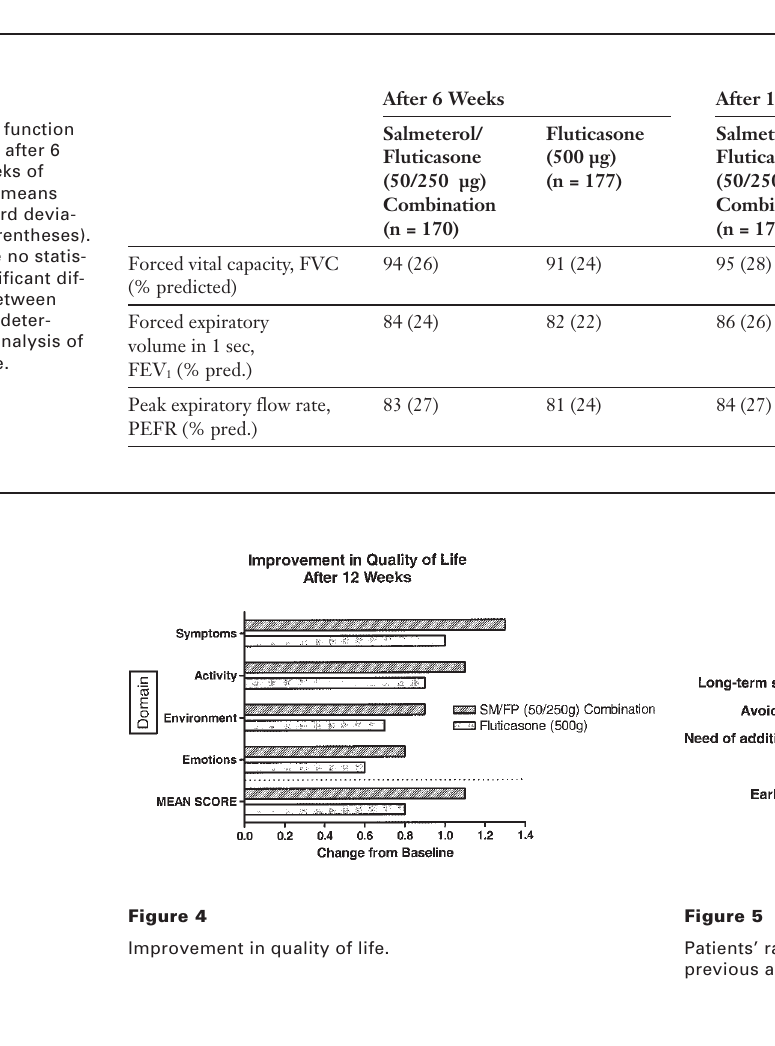
Figure 2 Mean morning (circles) and evening (squares) peak expiratory flow rates (l/min), as measured by patients during treatment.